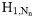
General neural network architecture used in this study [33, 43, 44].The input layer contains up to i input nodes, and the output layer is composed of 1, …, k output nodes. Nhl refes to the number of hidden layers, and each hidden layer is composed of Nn neurons. Each neuron (e.g., H1,1 … H1,Nn) is connected to the nodes of the previous layer with adjustable weights and also has an adjustable bias.